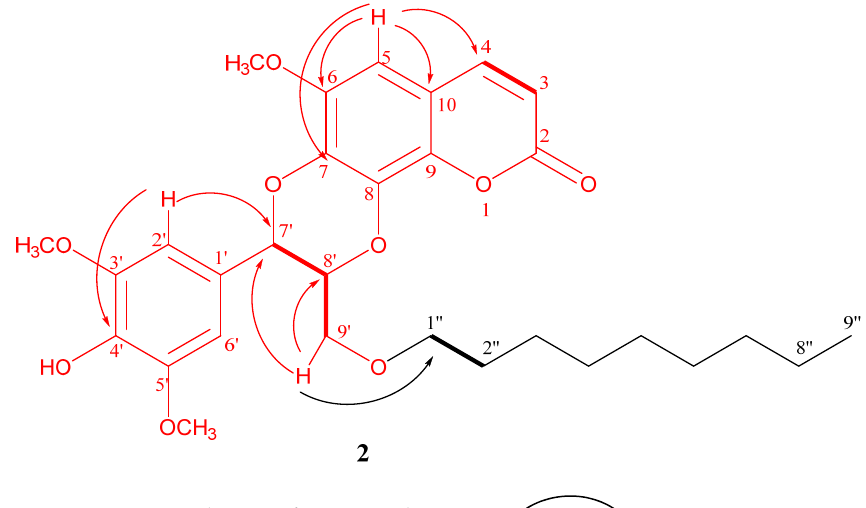
Figure 3. Some correlations of compound 2 HMBC and COSY . Table 2. 1 H (500 MHz) and 13 C (125 MHz) data of decyloxycleomiscosin D ( 2 ) in CDCl 3 :CD 3 OD (10:1).